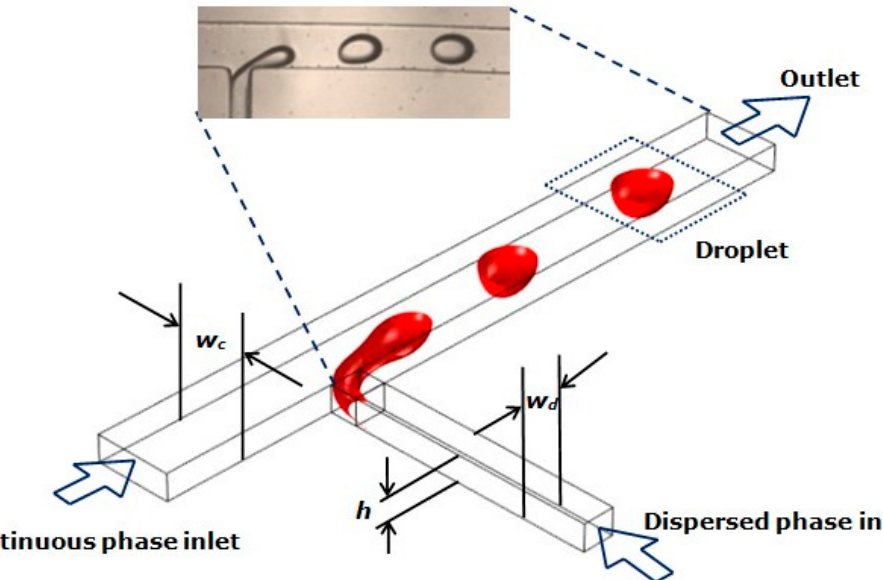
Figure 1. Schematic representation of the channel geometry and droplet formation.